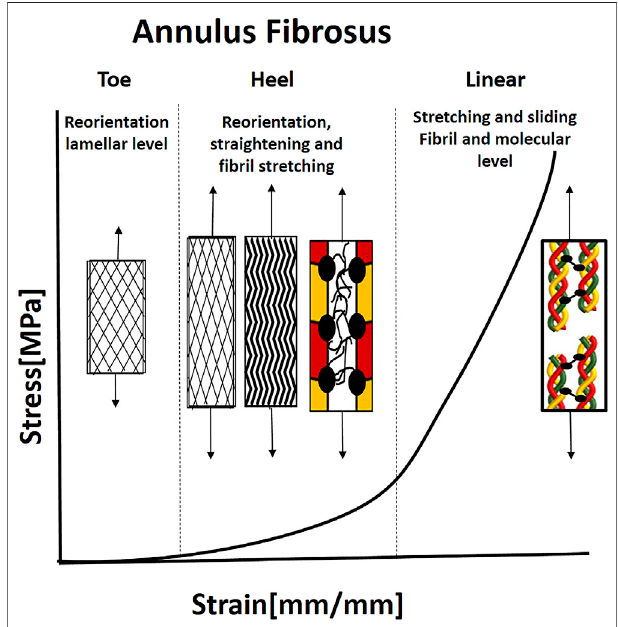
FIGURE 7 | Illustration of the J-shaped behavior under uniaxial tenion and mechanical mechanisms in the annulus fi brosus. For collagen fi brils to carry the load, they need to be straight and reorient in the loading direction. Therefore, the fi brils reorient in the loading directions, and the microscopic crimp straight in the toe and heel regions. When the fi brils are straight and recruited, they start to carry the load, and simultaneous sliding andstretchingstart,usingthePGs.Then,themolecularstretchofthecovalent cross-links and helix straightening taking place. Based on Guerin and Elliott